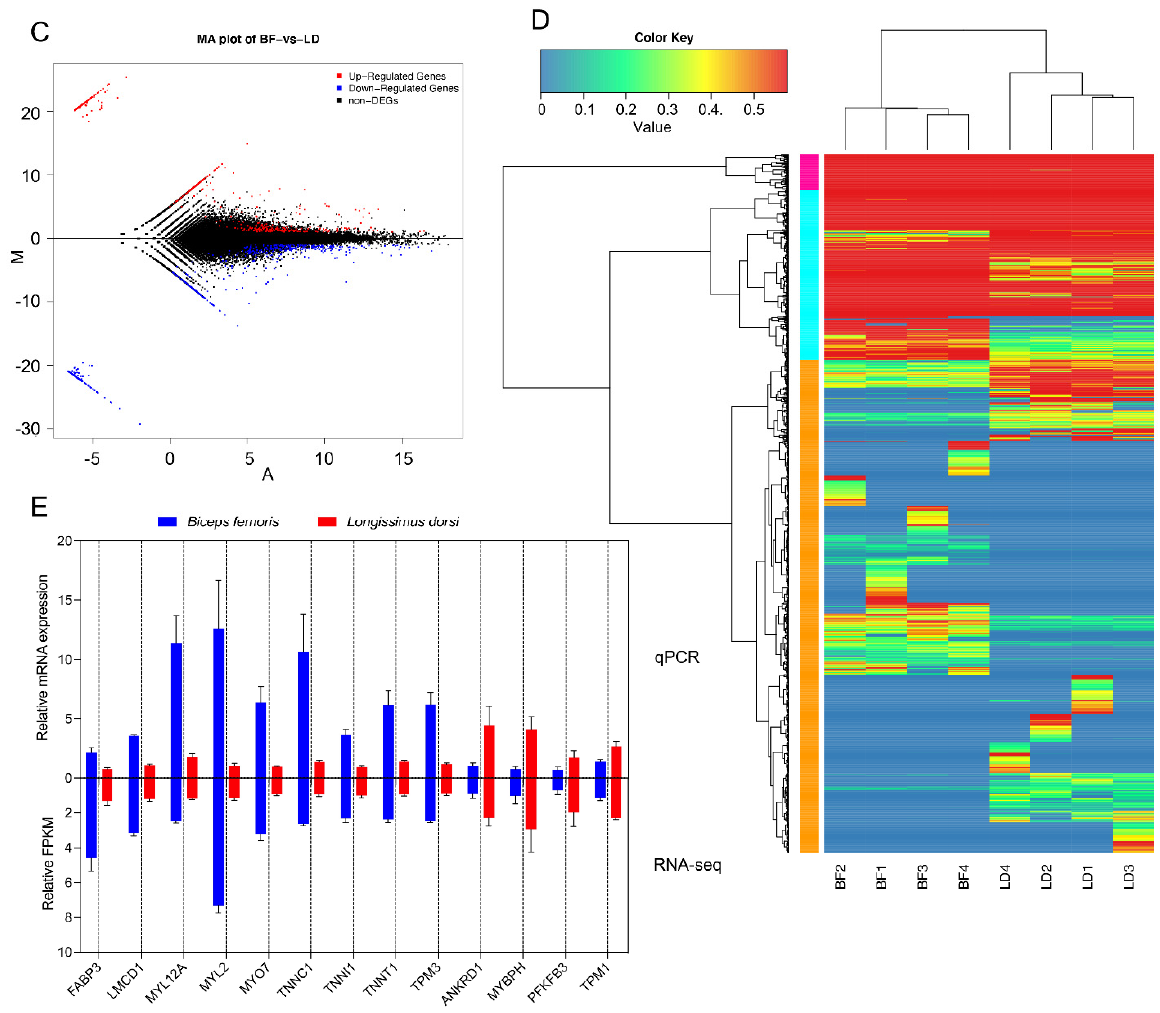
Figure 2. Short-read sequencing quantifies the expression of genes and transcripts of goat muscles. ( A ) Correlations between eight samples used for short-read sequencing. The correlation between each pair of samples in the sequencing libraries was calculated from the FPKM value. Samples with a Pearson’s correlation value ≥ 0.92 were considered as the same experimental replicates. The deeper blue color represents closer correlation between samples. ( B ) MA plot indicating differentially expressed genes between the BF and LD muscles. The red and blue dots represent the upregulated and downregulated genes in BF compared to LD muscles, respectively. |log2(FoldChange)| > 1 and padj < 0.05 is considered up- or downregulated. ( C ) MA plot indicating the differentially expressed isoforms between the BF and LD muscles. ( D ) Cluster enrichment of differentially expressed transcripts from LD and BF samples. The gradient color key represents the adjusted p -value, which is more significantly different when having more red color. ( E ) RNA-seq results are consistent with qPCR data. qPCR was used to verify the expression profiles of 13 randomly selected differentially expressed genes in RNA-seq results. The gene expression levels obtained from qPCR were normalized to GAPDH and are shown as mean ± standard error of mean (SEM) ( n = 4). Data from RNA-seq is shown as mean FPKM ± SEM ( n =